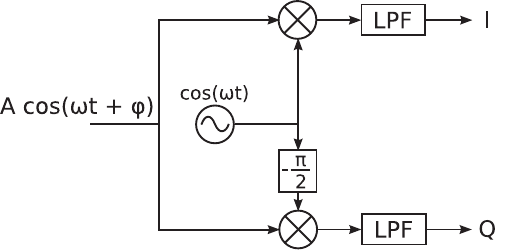
FIG. 17. Simplified scheme of an I=Q demodulator. The input signal is split and mixed with two sine waves at the same frequency as the input signal and a phase offset of π = 2 . These signals are low-pass filtered to remove the high-frequency mixing products.